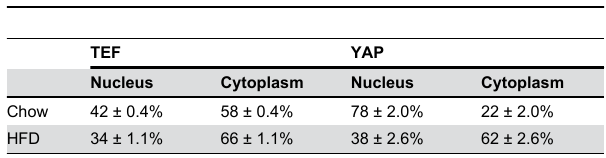
Table 1. Percent of nuclear vs. cytoplasmic TEF or YAP neurons.